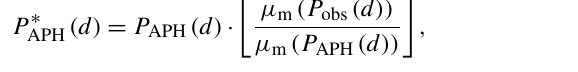
Figure 1. Locations of rainfall stations in the Yarlung Tsangpo– Brahmaputra River basin (YBRB).